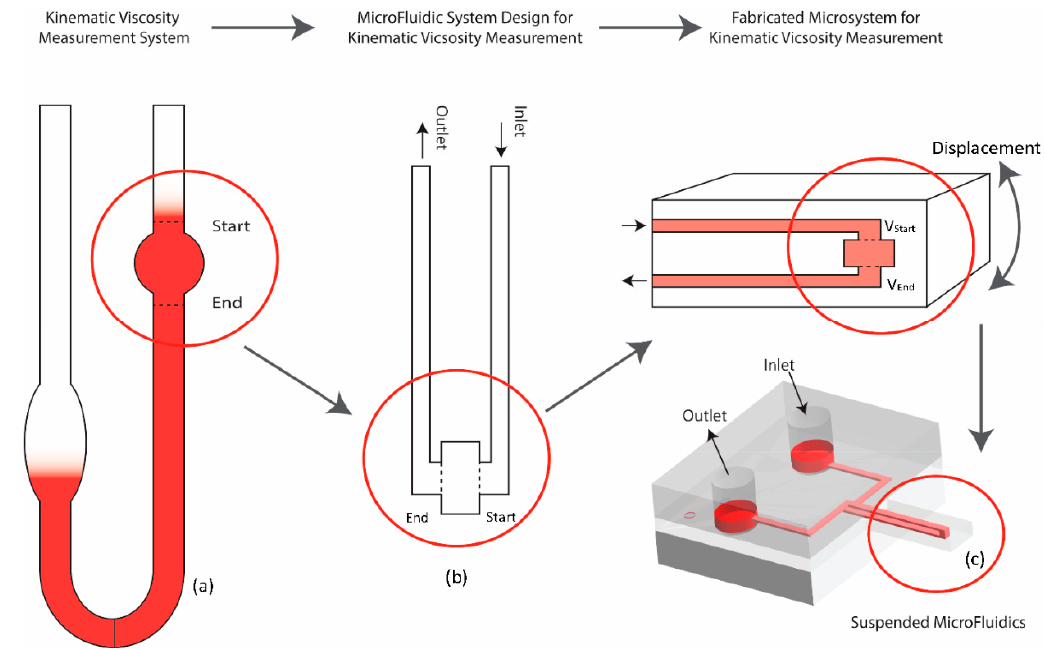
Figure 1. ( a ) Capillary kinematic viscosity measurement system, ( b ) Microfluidic system designed based on the capillary system, ( c ) Suspended microchannel designed to transduce and measure fluid forces.